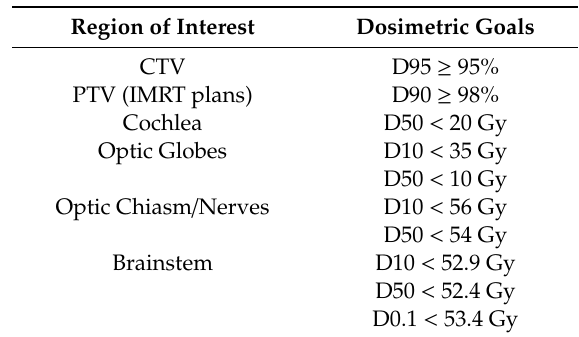
Table 2. Dose objectives used for plan